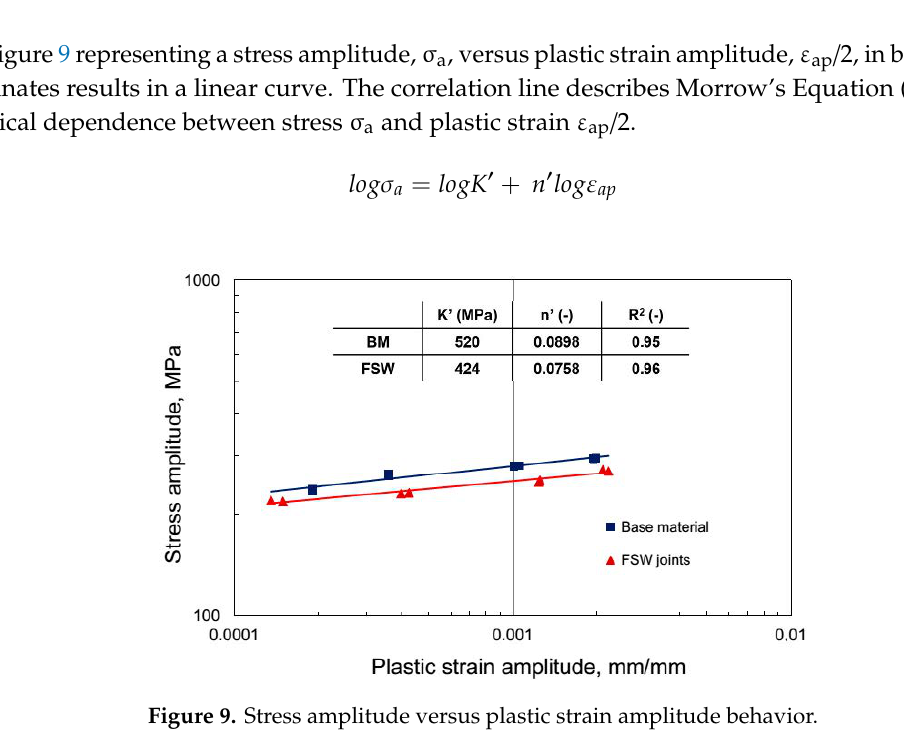
8 of 14 Figure 8. Examples of hysteresis loops for 0.5% total strain range: base material ( a ) and FSW joint ( b ). It was revealed by a decrease in the width of the hysteresis loop shown in Figure 8, with the simultaneous sharp increase in the values of the range of stress for both: base material (Figure 8a) and FSW joint (Figure 8b).The observed effect of the increase in stress range under the influence of strain for the AA5083 alloy can be explained by the increase in dislocation density and the mechanism of solid solution operation and the presence of a fine second phase (Al6Mn) recognized in the literature [28]. Figure 9 representing a stress amplitude, σ a , versus plastic strain amplitude, ε ap /2, in bilogarithmic